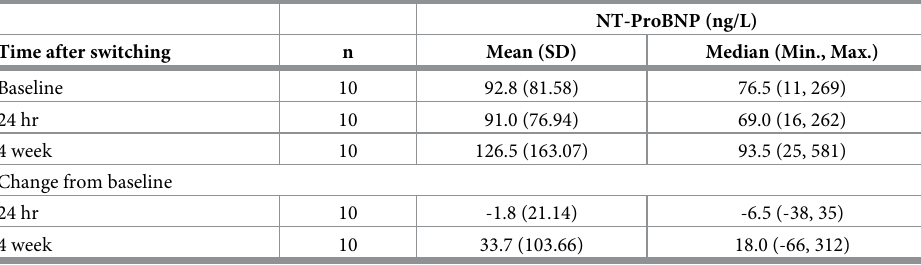
Table 5. Change from baseline in